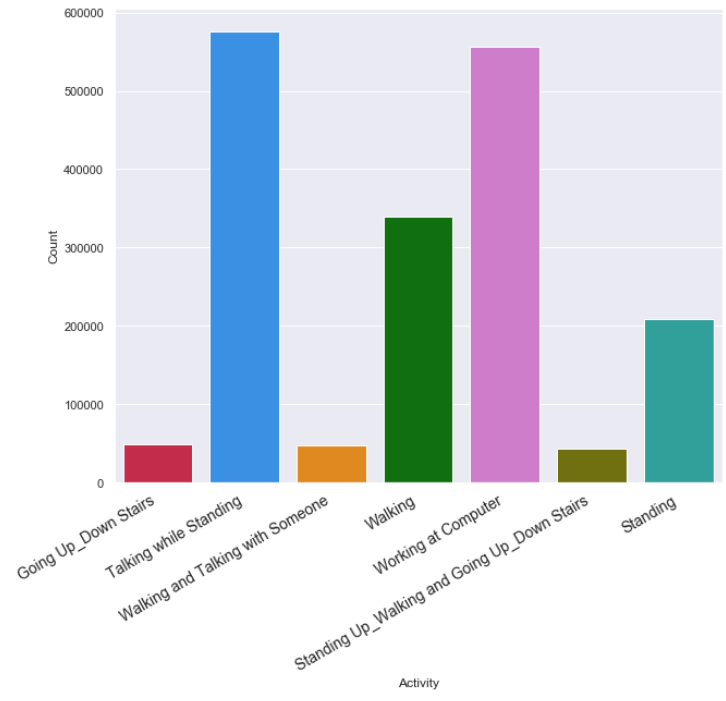
Figure 6. Activity record count in Single Chest clean